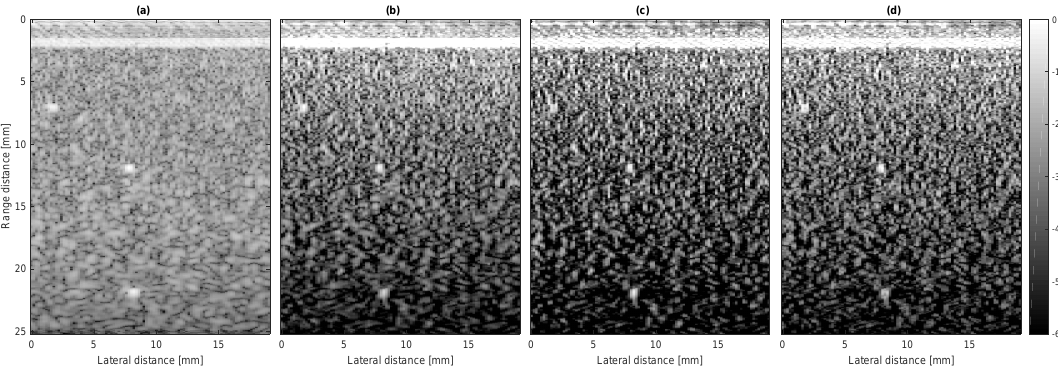
Figure 2. B-mode images of string phantom obtained ( a ) with delay-and-sum (DAS); ( b ) with modified amplitude and phase estimation (mAPES) beamforming without gPCF, and mAPES beamforming with gPCFs evaluated ( c ) before and ( d ) after applying the adaptive beamformer weights.